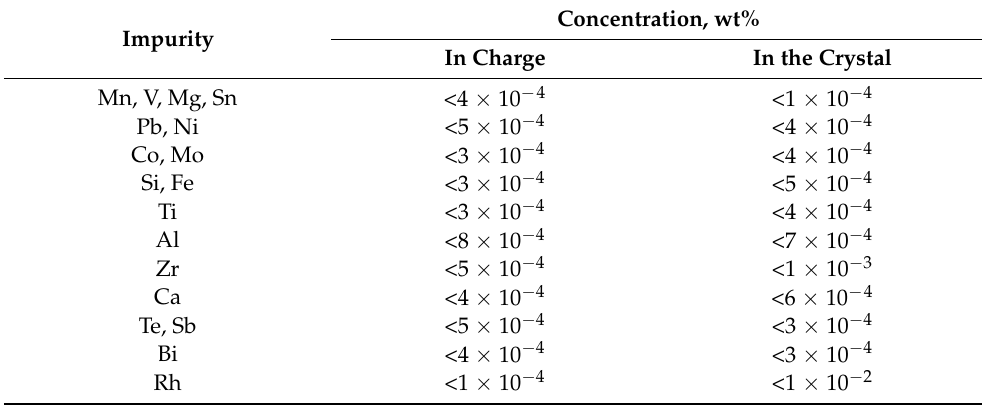
Table 1. Impurity composition of the initial LT charge and LiTaO 3 :Cr(0.2):Nd(0.45 wt%) crystal.